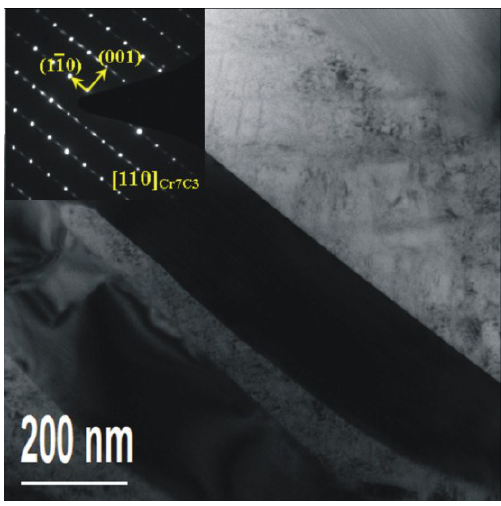
Figure 9. TEM and corresponding diffraction patterns of the Cr 7 C 3 in the